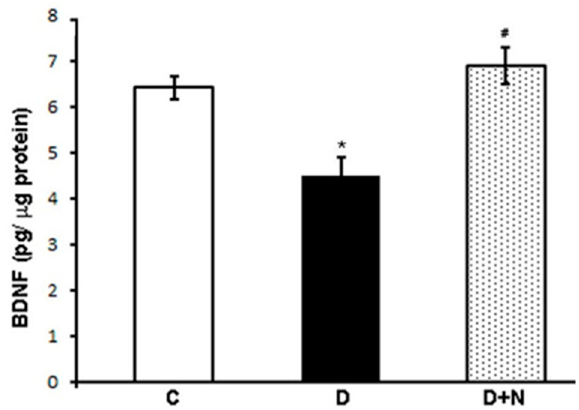
Figure 2. Brain derived neurotrophic factor (BDNF) concentration in the retina of control, naringenin-treated, and non-treated diabetic rats. Values are means ± SEM; n = 6/group. * ,# p < 0.05 compared to control and diabetic rats, respectively. C represents control, D as diabetic, and D + N as naringenin-treated diabetic rats.